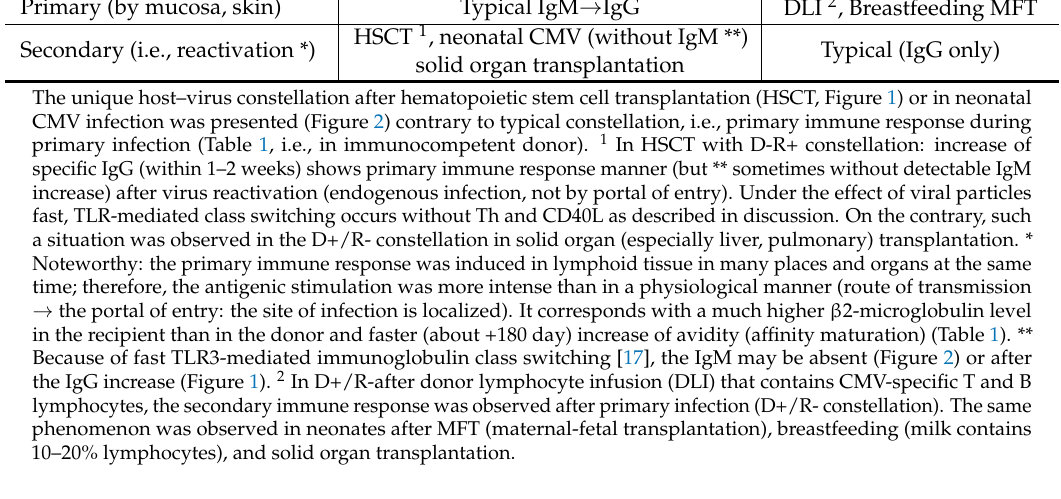
Table 2. The unique host–virus constellations and populations at risk in transplantology and obstetrics.